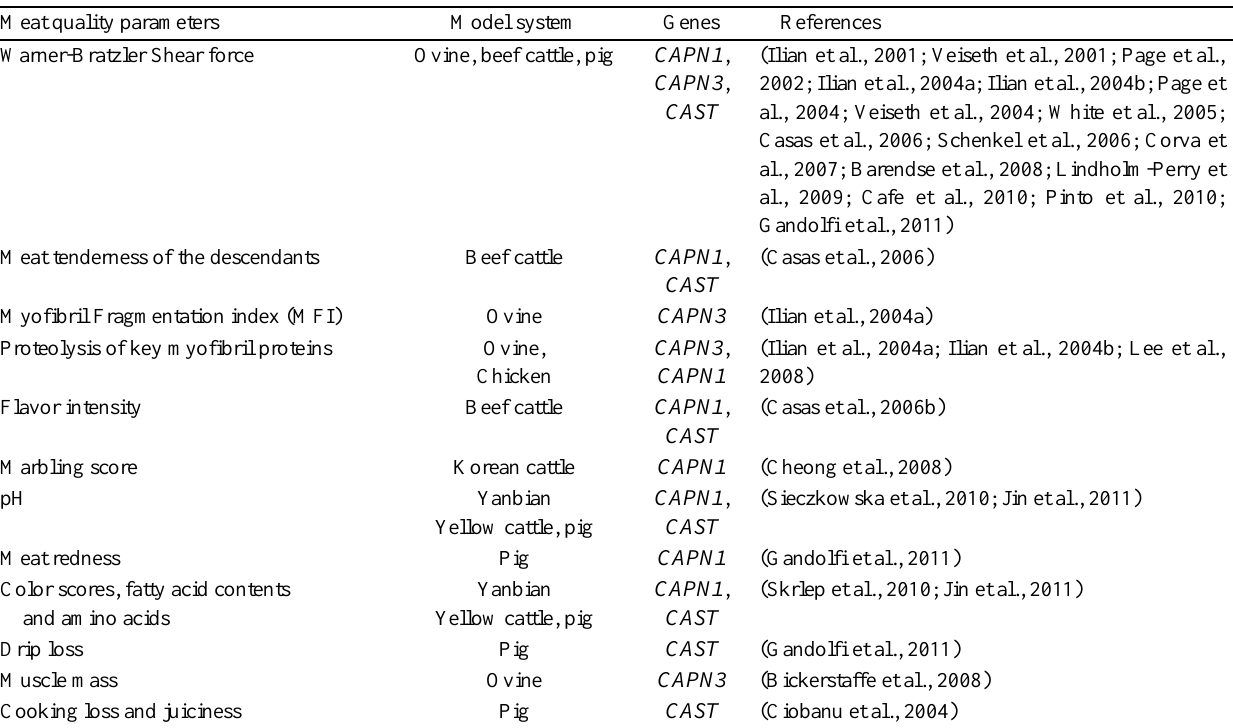
Table 1. CAPN1 , CAPN3 and CAST genes associated with meat quality Meat quality